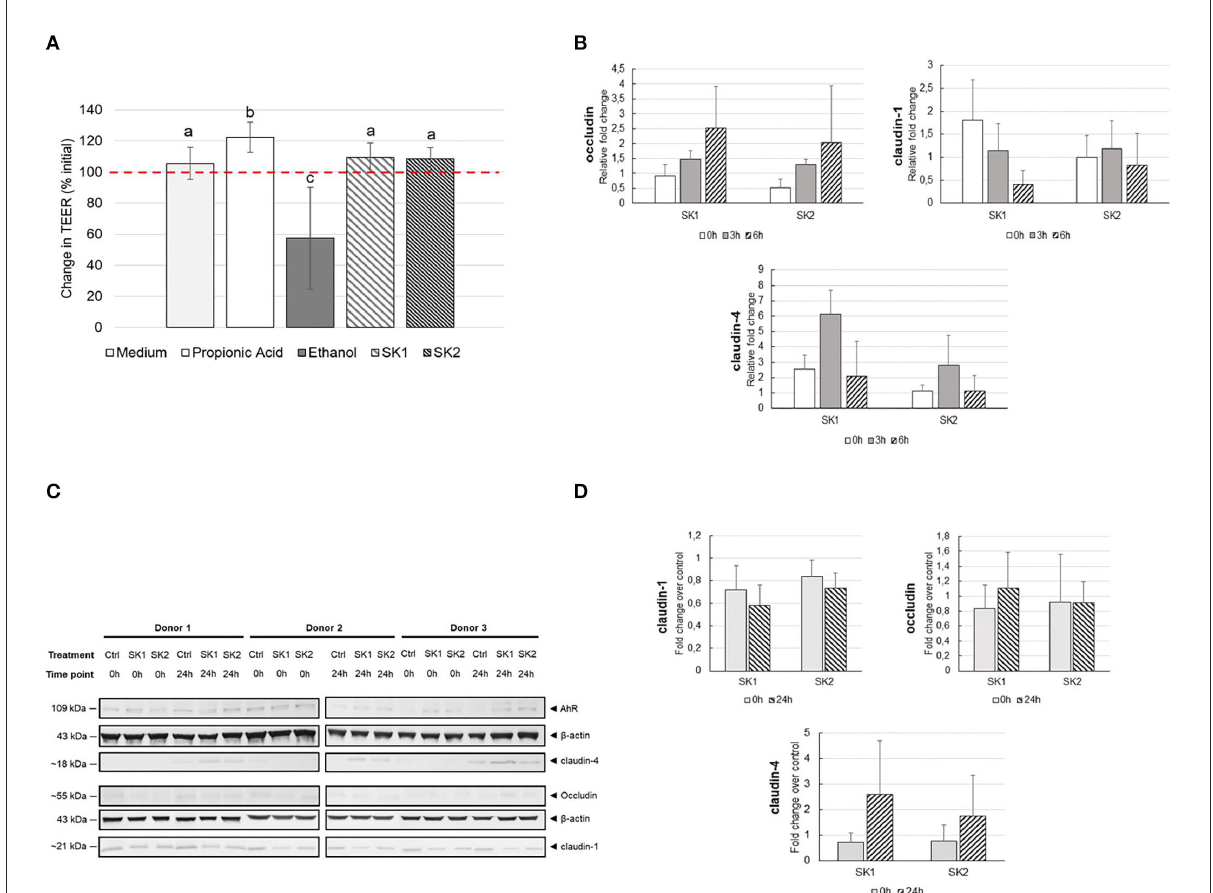
FIGURE5 (A) Changes in trans-epithelial electrical resistance (TEER) across differentiated Caco-2 monolayers after 24h of incubation in the presence/absence of 10% SK brine or control medium (TEER 24h ( Ω cm 2 )/TEER 0h ( Ω cm 2 ) × 100%). The threshold (100%) indicates the baseline TEER value. Different superscript letters indicate statistical significance between test substrates. (B) Gene expression of TJ proteins in Caco-2 cells after stimulation with 10% SK brine in Caco-2-PBMC co-culture in vitro model. Histograms represent the mean and error bars represent the standard deviation ( n = 3). (C) Quantification of TJ proteins by Western blot. The molecular weight of each protein is described on the left side of the image. β -actin was used as the reference protein. Densitometric analysis by ImageJ software. (D) Fold change TJ protein